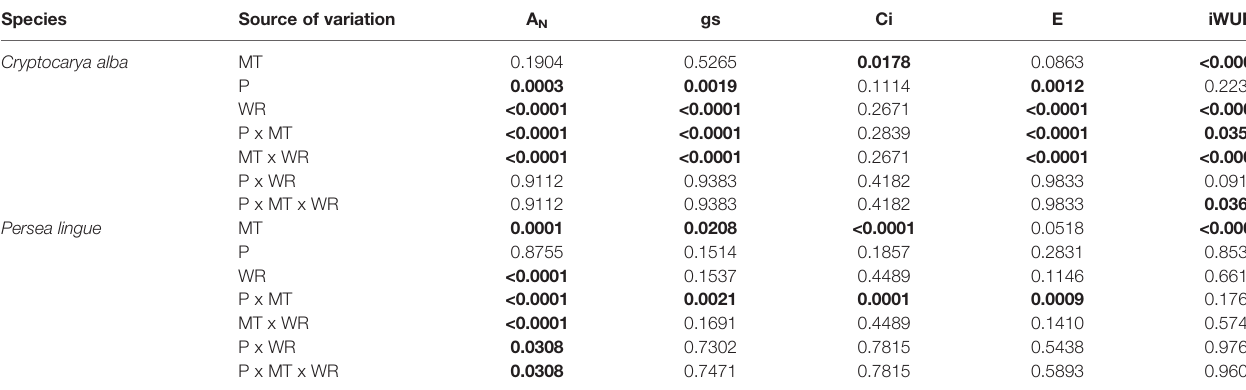
TABLE 2 | Summary of three-way repeated measures ANOVA p-values for treatment effects on net photosynthesis (A N ), stomatal conductance (gs), intercellular CO 2 concentration (Ci), transpiration rate (E), and intrinsic water use ef fi ciency (iWUE) in Cryptocarya alba and Persea lingue plants. Species Source of variation